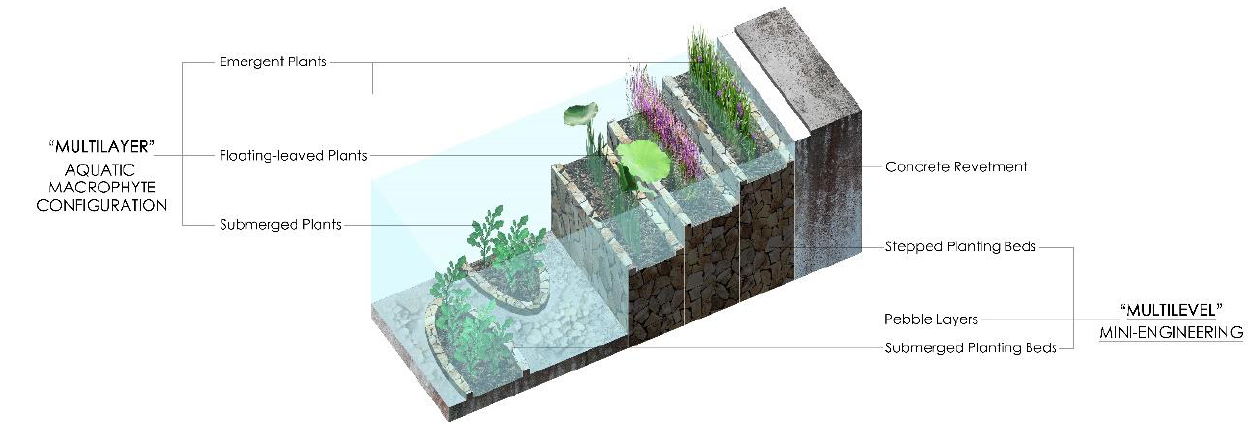
Figure 9. Sectional perspective of the in situ ecological self-purification model.